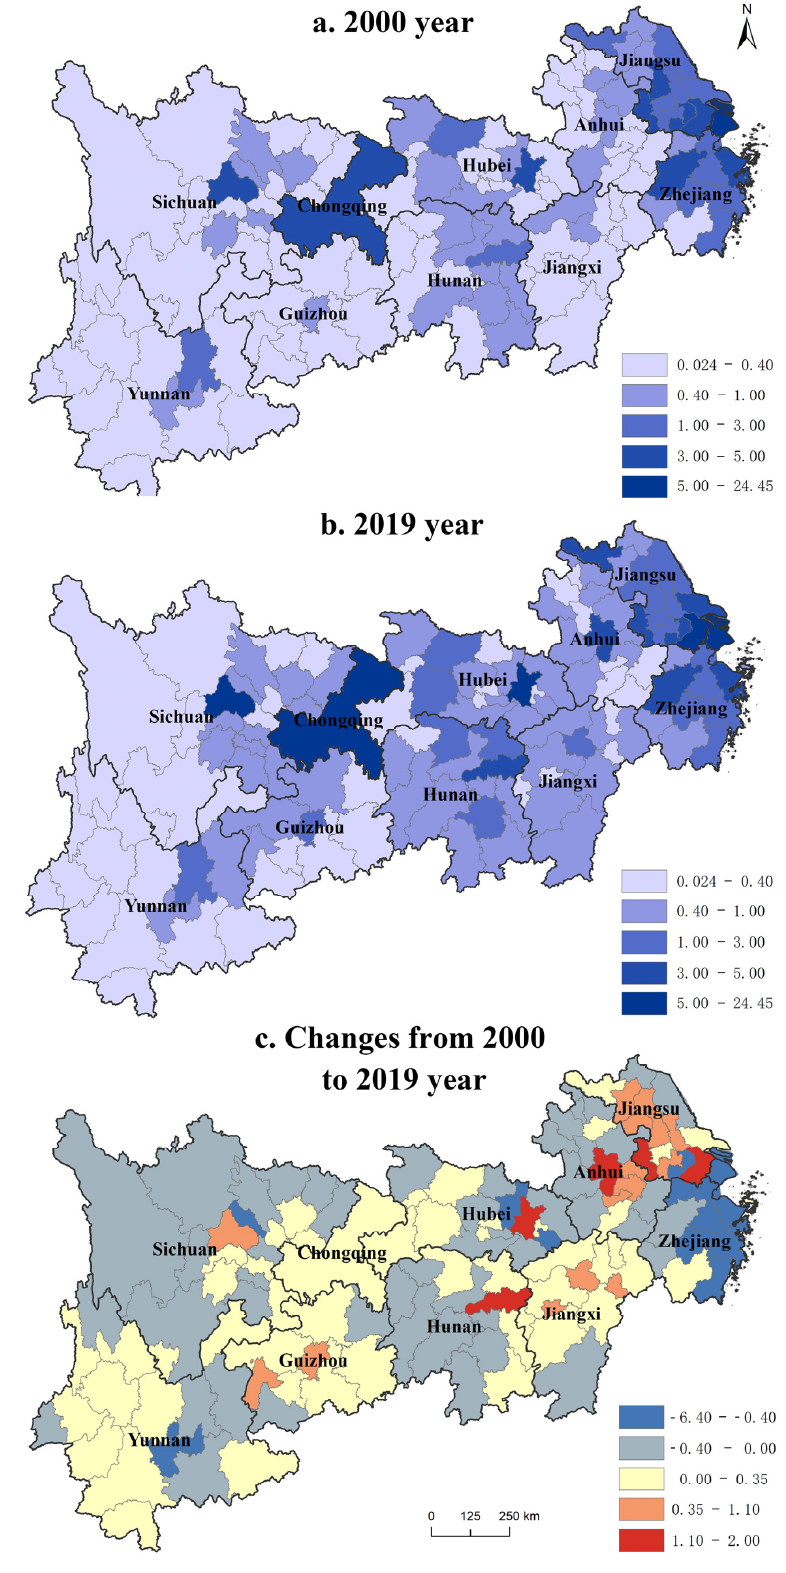
Figure 4. The evolution pattern of economic geographic concentration from 2000 to 2019.